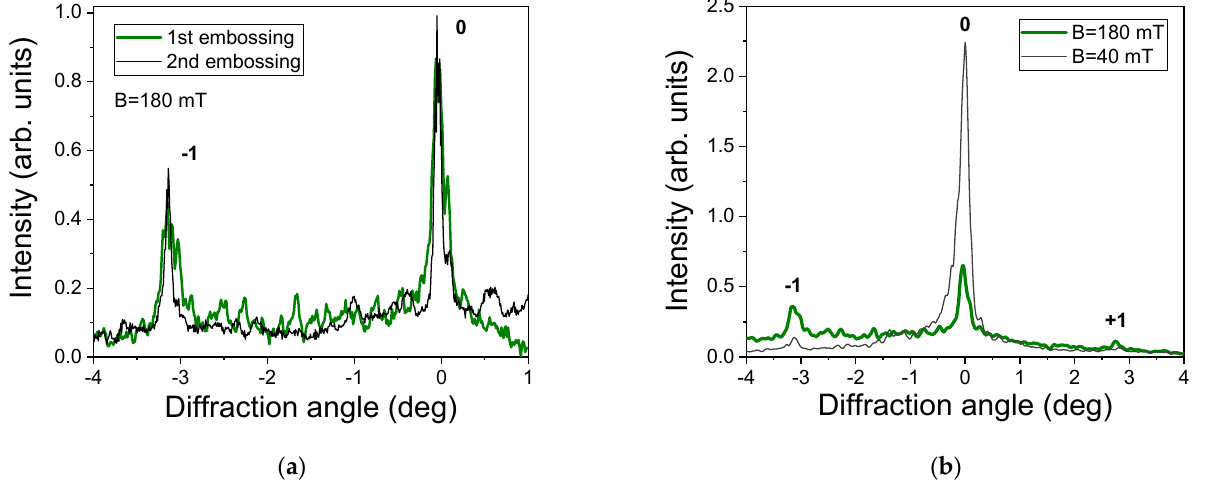
Figure 4. ( a ) Transversal profile of the far ‐ field optical diffraction patterns observed as outcomes of two separate embossing processes in sample M2. Both diffraction measurements were performed at B = 180 T. In between the two embossing episodes, the sample was removed from the magnetic field for several hours. ( b ) Far ‐ field optical diffraction pattern observed at B = 180 mT (thick green line) and at B = 40 mT (thin black line). The value of B was slowly reduced from 180 mT to 40 mT in steps of about 20 mT.